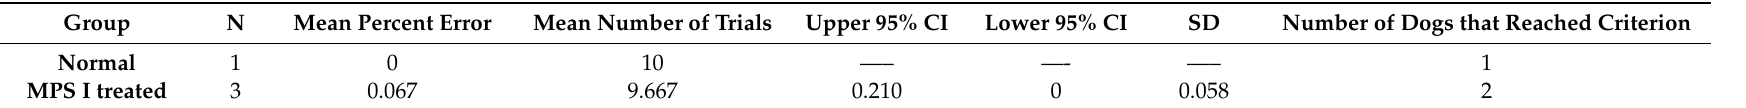
Table 6. DNMP descriptive statistics by group for 40-s delay. This includes the number of dogs tested (N) from each group, mean (real) percent error of each group, mean (real) number of trials performed by each group, 95% confidence interval, standard deviation, and number of dogs from each group that reached the criterion at the 40-s delay.